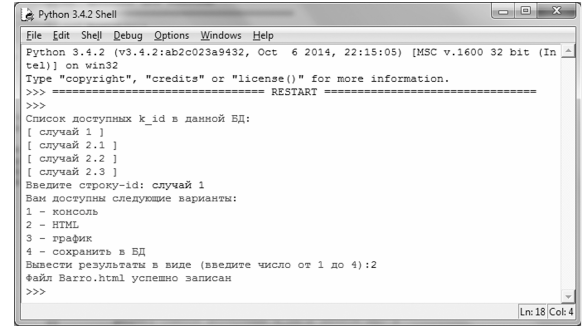
Fig. 5. Working with the program in ”HTML” output mode.